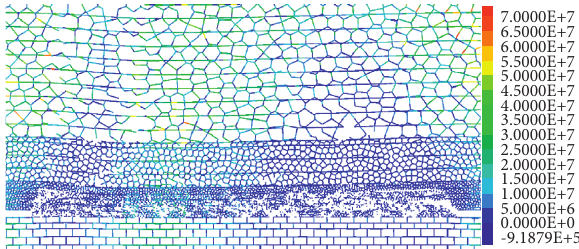
Figure 10: Contact force between blocks in longwall mining.